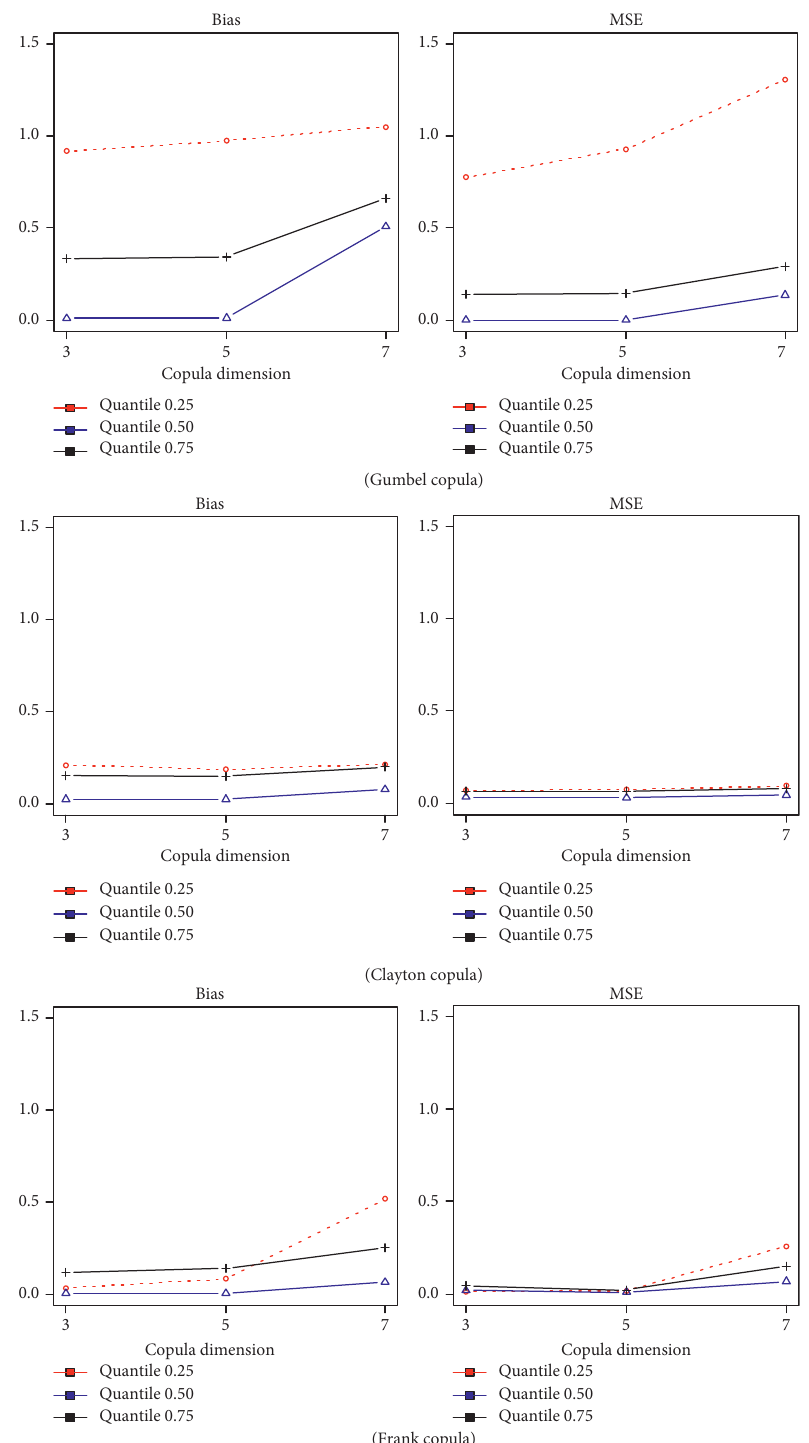
Figure 2: Absolute Bias (first column) and MSE (second column) of the estimates of θ α α � ( 0 . 25 , 0 . 50 , 0 . 75 ) , where R � 1,000